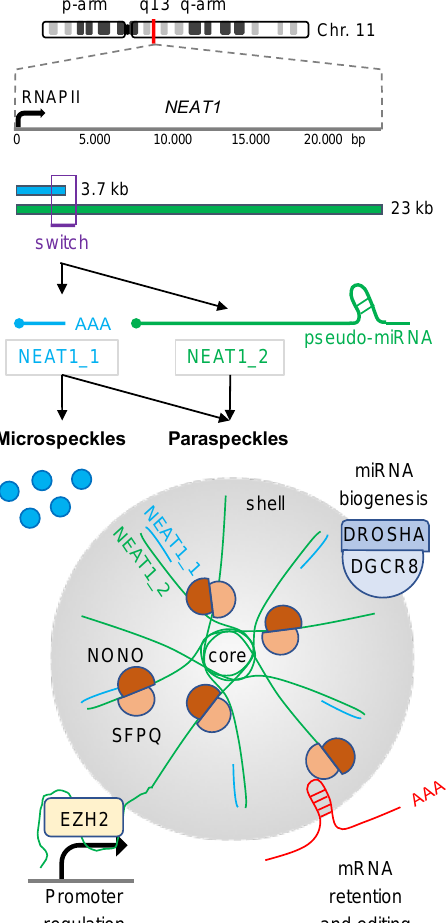
Figure 1. Two NEAT1 isoforms modulate gene expression at the transcriptional and posttranscrip- tional level. The human NEAT1 gene is located on chromosome 11q13 (red line) and encodes two overlapping isoforms, NEAT1_1 (blue) and NEAT1_2 (green), which are both produced by RNAPII transcription. NEAT1_1 synthesis requires cleavage and polyadenylation (AAA) at the size of 3.7 kb (isoform switch region, purple box), whereas NEAT1_2 is 23 kb long and a of suppressed poly- adenylation and contains a pseudo-miRNA hairpin and a triple helix structure at the 3′ end. NEAT1_1 is present in both microspeckles (blue) and paraspeckles (grey); both not essential. NEAT1_2 is the essential structural component of paraspeckles, which are membrane-less nuclear condensates that comprise a core-shell arrangement and form via phase separation. Paraspeckles contain more than 40 RNA binding proteins such as NONO and SFPQ, and modulate the RNA metabolism by three major mechanisms: (i) the recruitment of the DROSHA/DGCR8 microprocessor complex (purple) to stimulate miRNA biogenesis, (ii) the retention and editing of a subset of mRNAs (red), and (iii) the modulation of protein-coding gene promoters (black arrowhead) by scaffolding chromatin modifying enzymes such as EZH2.